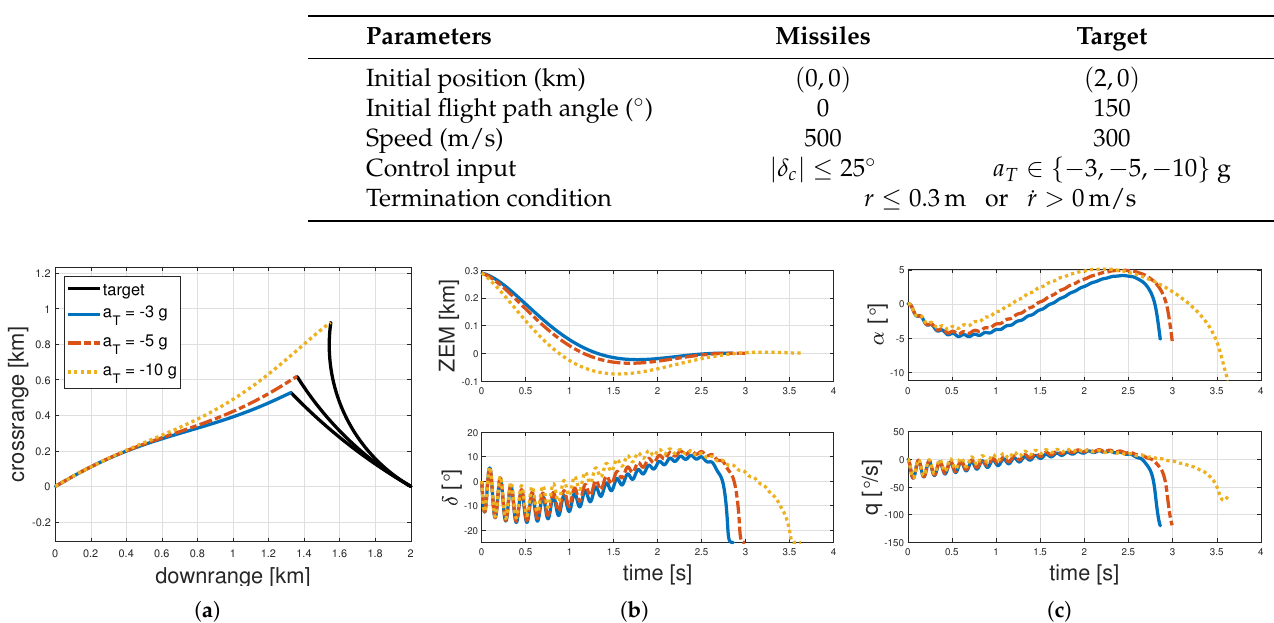
Table 1. Simulation settings.